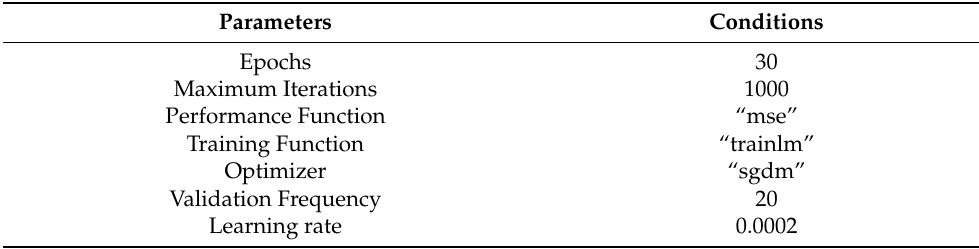
Table 1. Proposed CNN parameters.